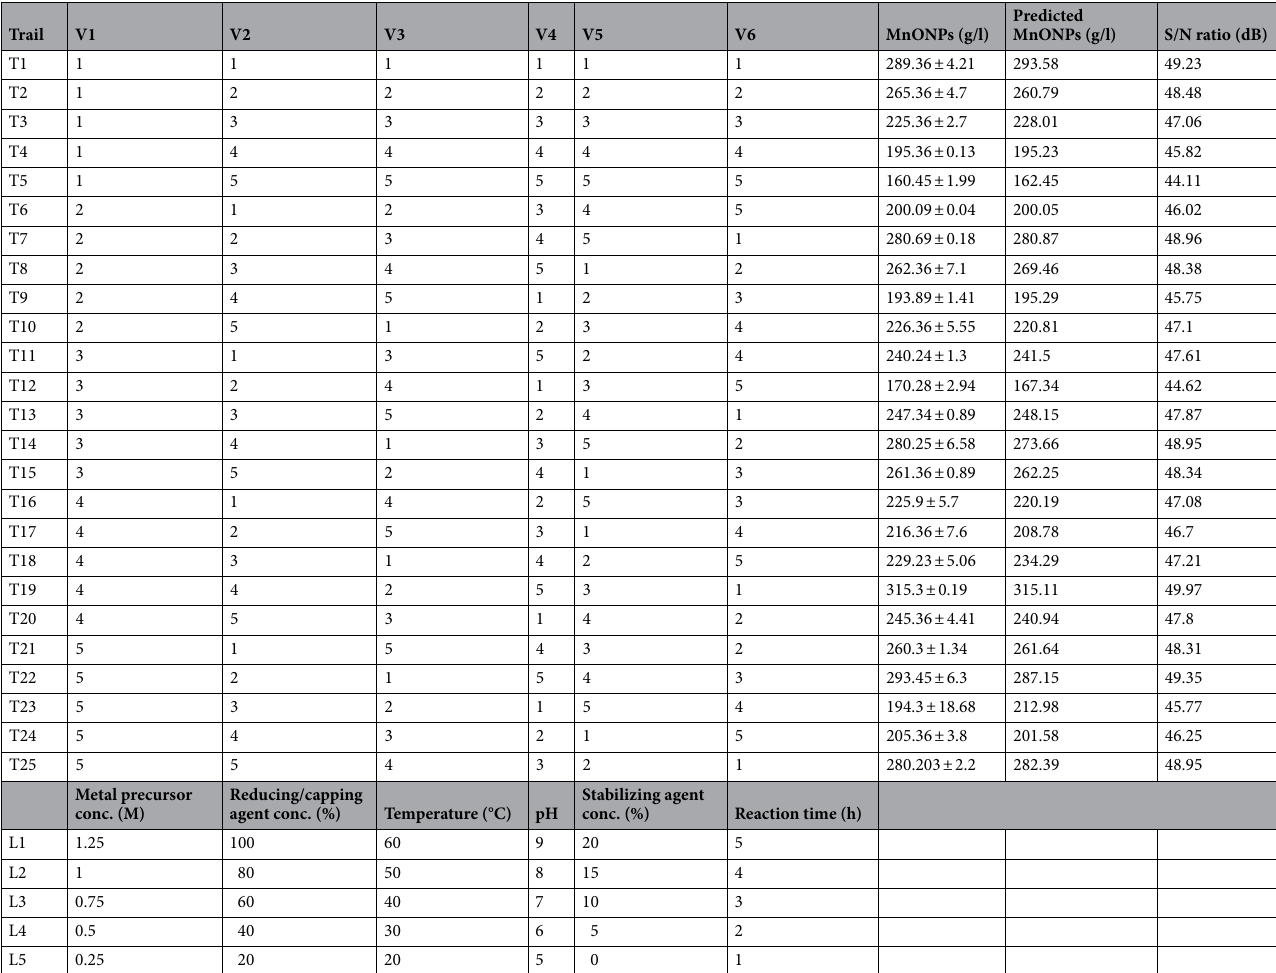
Table 7. Matrix of Taguchi experimental design for optimizing the MnO NPs biogenic production using endophytic Trichoderma virens strain EG92 extract.